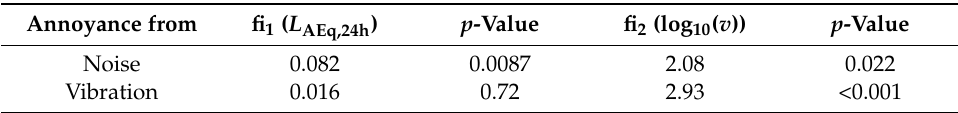
Table 7. Estimated coefficients for logistic regressions of annoyance from noise and vibration in area 2 (noise and